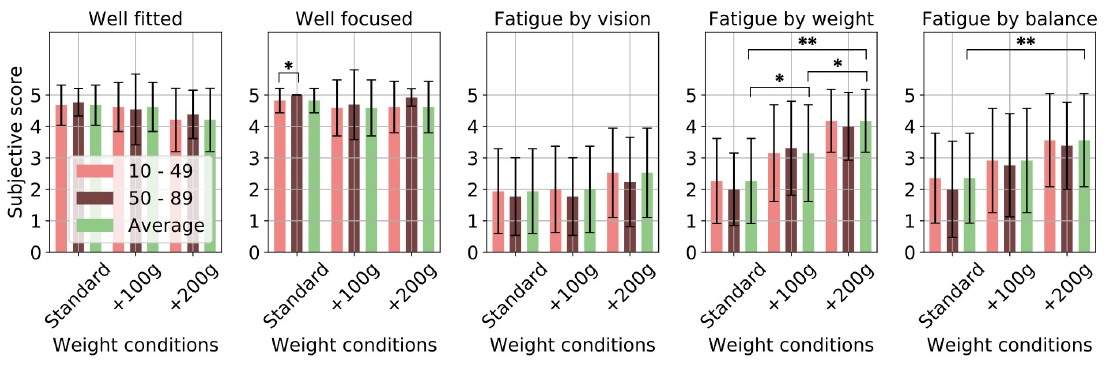
Figure 5. Questionnaire results for female participants in the “front” group. The results of Q1 to Q5 are shown from left to right. (*: p < 0.05, **: p <